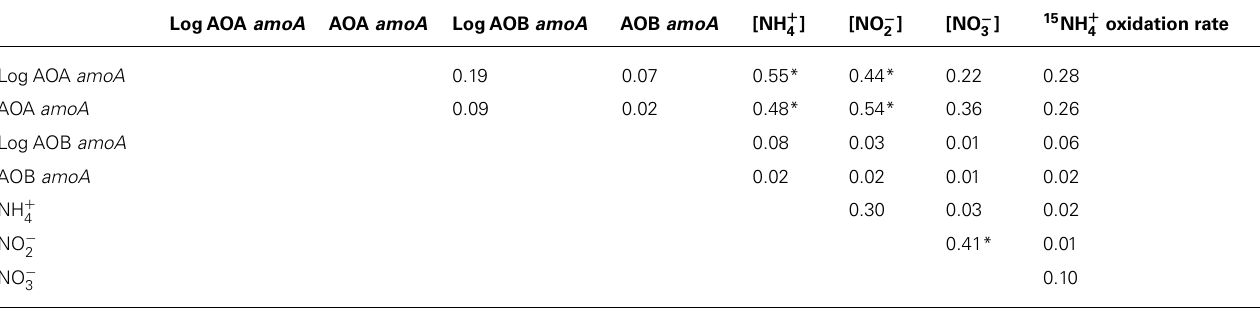
Table 2 | Correlation coefficients ( r 2 ) for comparisons between qPCR data, nutrient concentrations, and 15 NH + triplicate cores collected in Catalina Harbor in